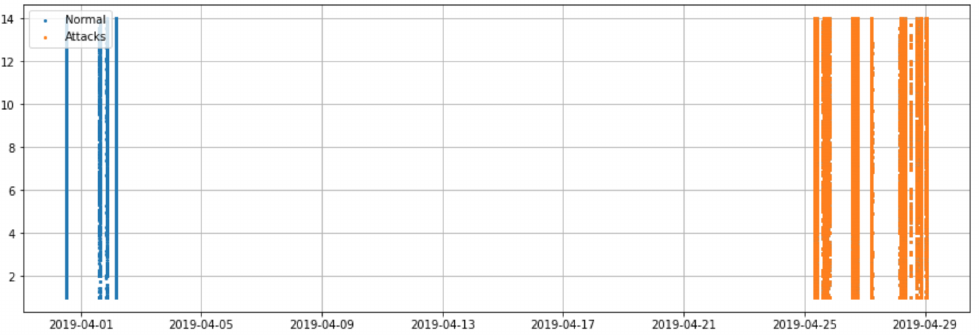
Figure 2. Normal and attack events for temperature feature of smart